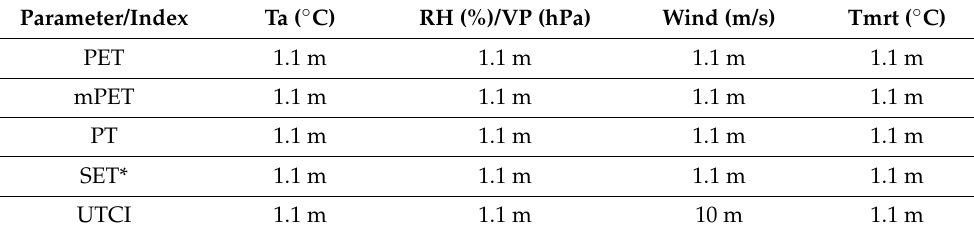
Table 2. Required measurement/input height for all meteorological input parameters and ther- mal